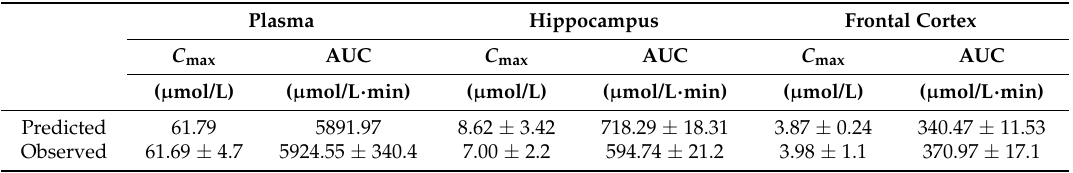
Table 4. Summary of predicted and observed pharmacokinetic parameters of carbamazepine in plasma and hippocampus brain regions in rats.